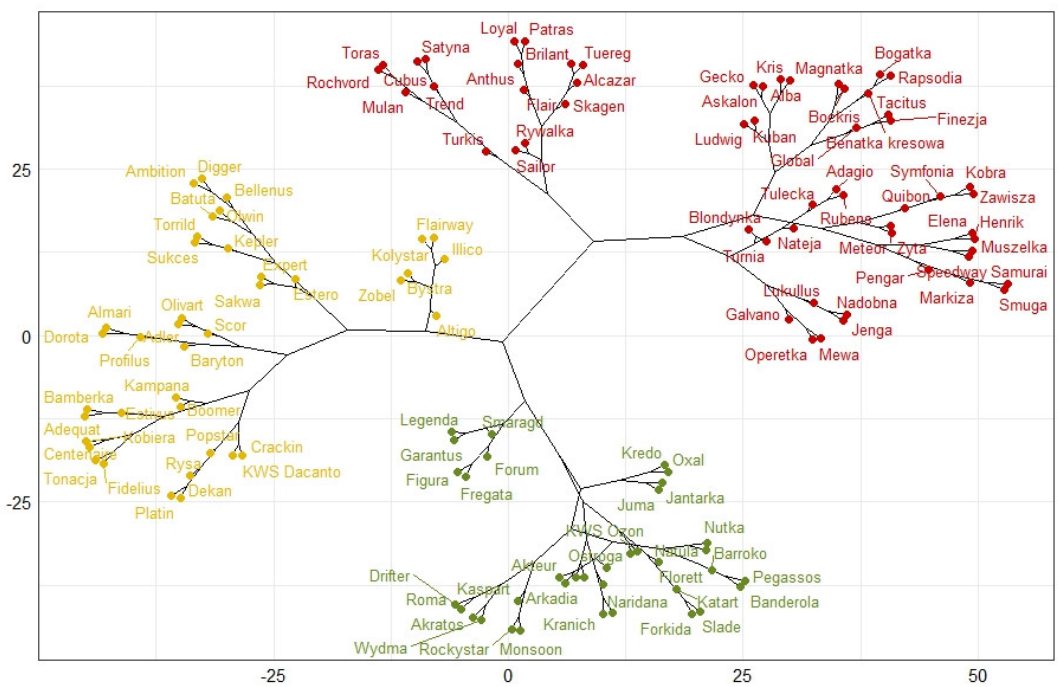
ble, yellow−less susceptible, green−least susceptible.